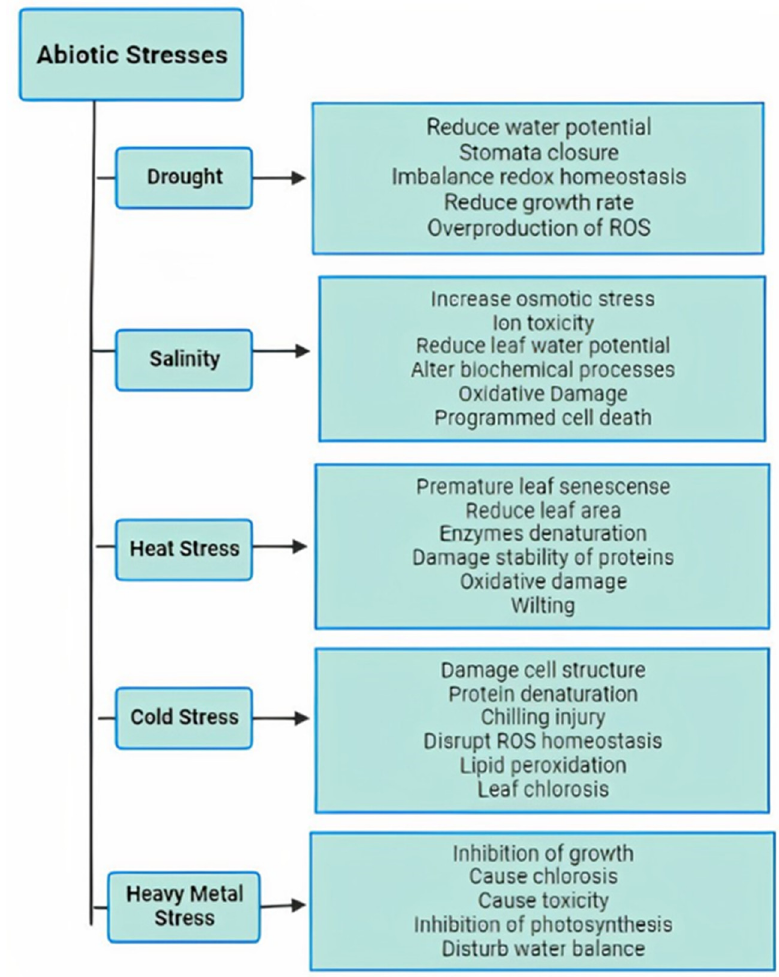
Figure 1. The negative impacts of abiotic stresses on plants. Figure 1 . The negative impacts of abiotic stresses on plants. Antioxidants are the key elements that protect plants from the oxidative damage caused by abiotic stresses. Melatonin acts as an effective antioxidant against different abiotic stresses and enhances certain physiological activities, including osmotic regulation, growth, germination, photosynthesis, primary and secondary metabolism, anti-senescence,